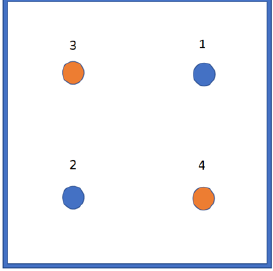
Figure 2. Schematic of capillary placement in a RADiCAL module as seen from the beam entry (upstream) face. In the arrangement shown, positions 1 and 2 are for T-type capillaries; positions 3 and 4 are for E-type capillaries; however, all four capillaries could be used for energy measurement (E-type) or for timing measurement (T-type), depending upon experimental preference.